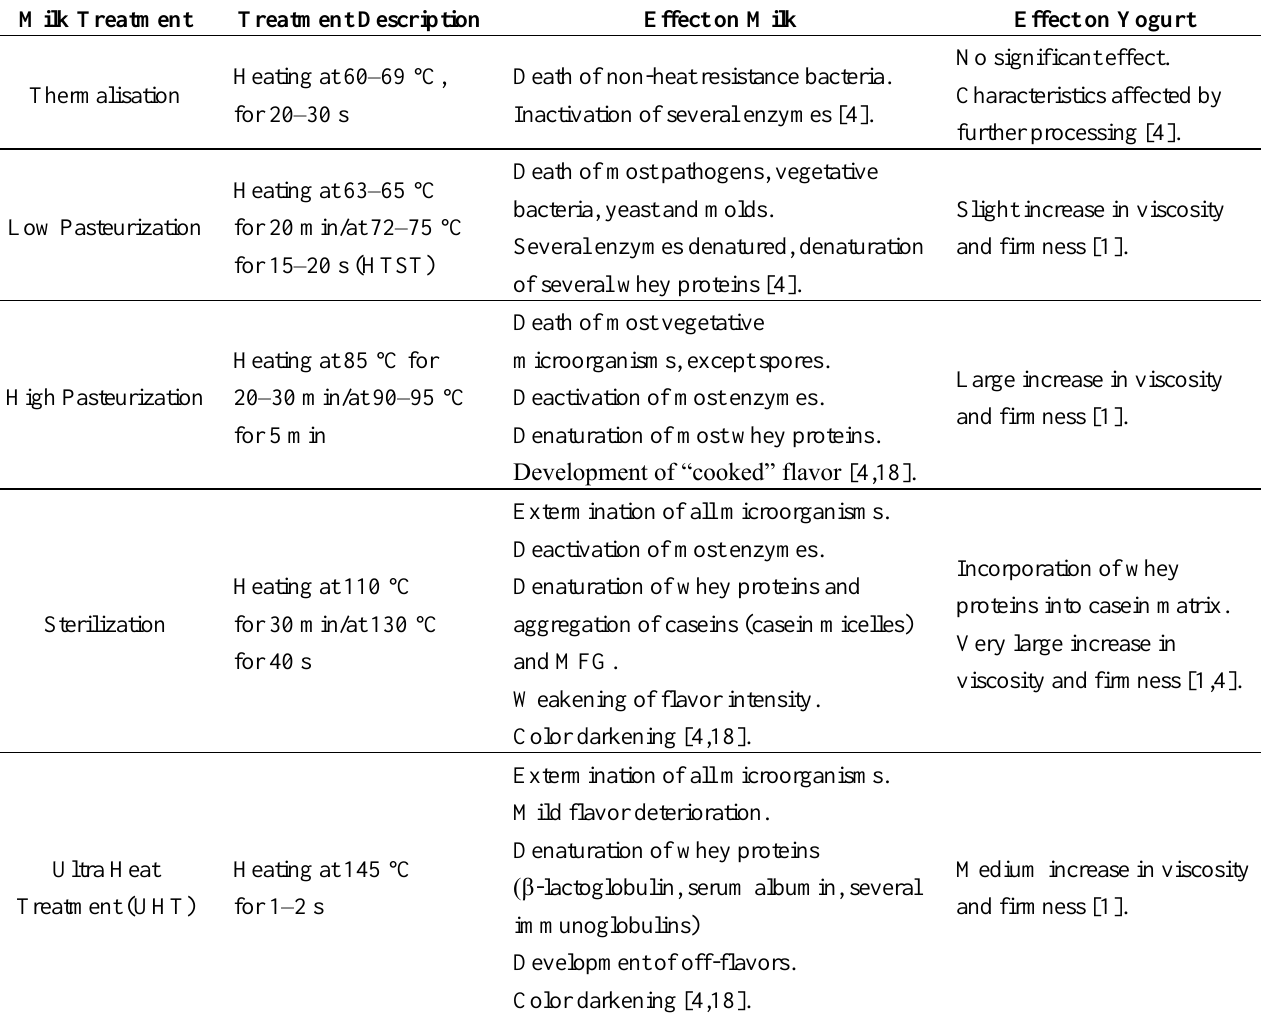
Table 1. Impact of different thermal treatment techniques on milk and yogurt properties affecting flavor and